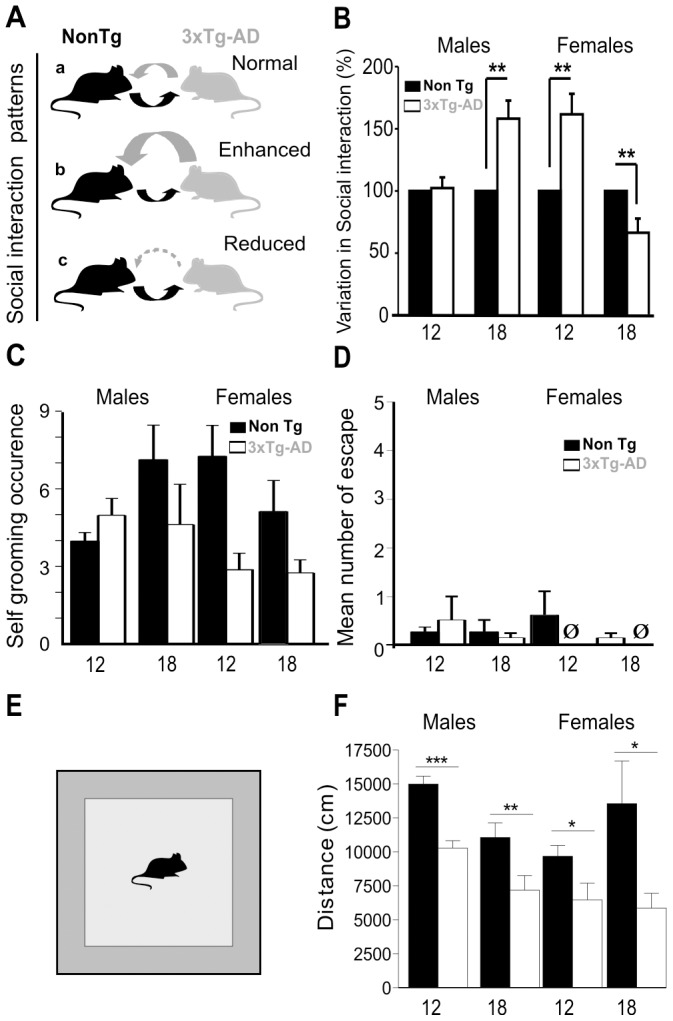
Sex-dependent behavioural abnormalities emerge at different ages in 3xTg-AD mice.(A) Behavioural paradigm used to study social interactions in 12-month-old and 18-month-old male and female 3xTg-AD mice, along with age- and sex-paired non-transgenic controls (NonTg). Based on the number of social events recorded during experiments, 3 different patterns of social interaction were observed, as depicted from (a) to (c). (B) A marked increase in social interactions was seen in 3xTg-AD females as early as 12 months of age, when compared to NonTg controls, while no difference was observed in males. However, 3xTg-AD males displayed such a social disinhibition after reaching 18 months of age when compared to age- and sex-matched NonTg animals. In contrast, the social behaviour of 18-month-old females was markedly reduced. Social events were expressed as means ± SEM. **p<0.01, n = 8 per group. No difference in self grooming (C) or escape behaviour (D) were observed. (E and F) 3xTg-AD mice travelled less in an open field task. Ø indicates that animals of the group did not demonstrate this behaviour.